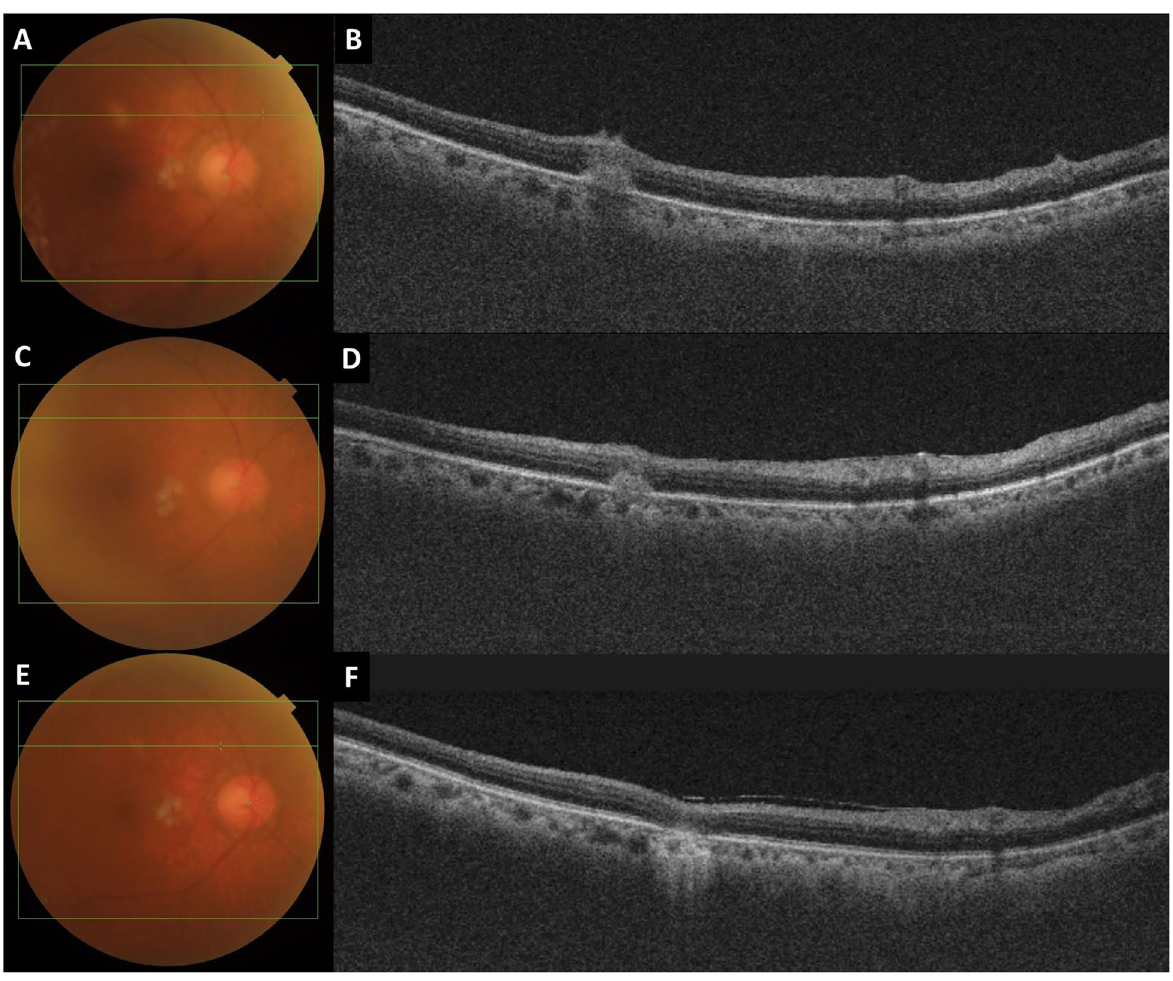
Fig. 3 Serial fundus photographs and SS-OCT scans passing through a choroiditis lesion of the right eye showing a dome-shaped hyper-reflective lesion involving outer and inner retina at baseline. A , B At 2-month follow-up, the lesion became more well-circumscribed and decreased in size ( C , D ). At 6-month follow-up, the lesion disappeared, resulting in loss of outer retinal